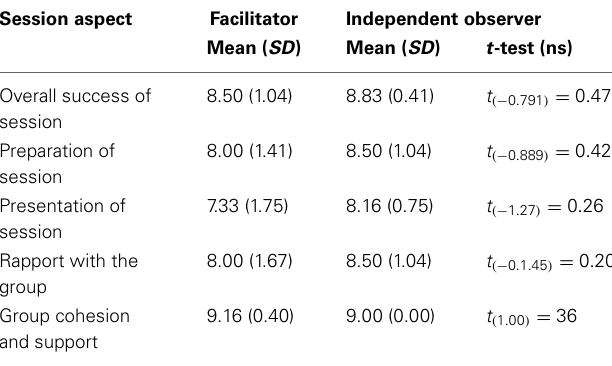
Table 5 | Mean observers and facilitators ratings for five rating scales on a scale of